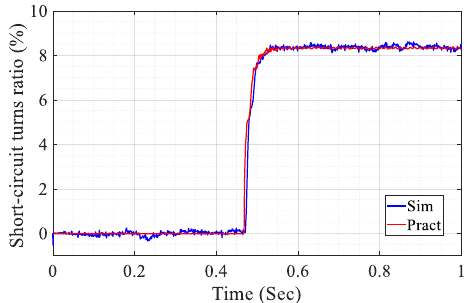
Figure 26. Estimation of 8% short circuit turns ratio in phase A.